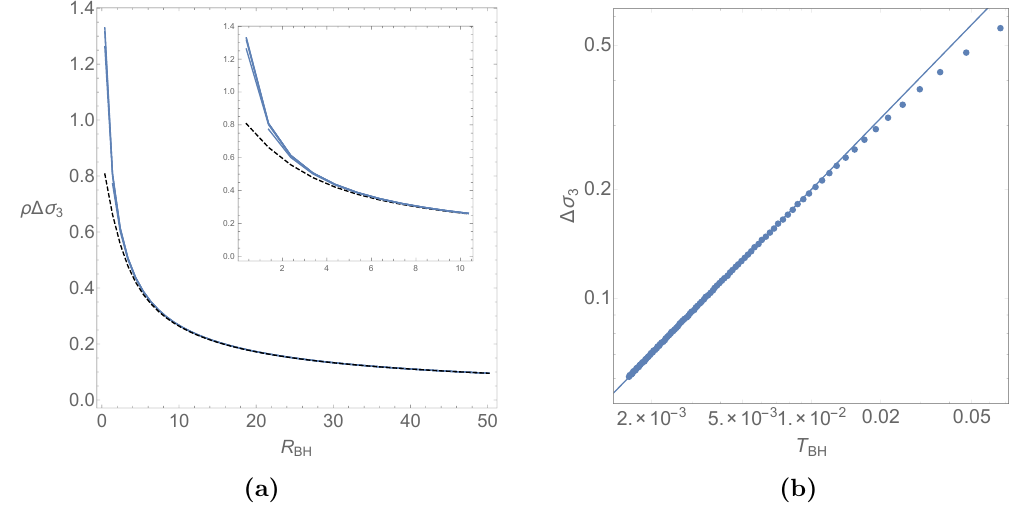
Figure 7. In (a), we plot (cid:26) (cid:1) (cid:27) 3 for (cid:26) = 1 (black, dotted line) ; 2 ; 3 ; 10 ; 20 ; 100 as a function of R BH . In scaling by (cid:26) , the area curves nearly perfectly overlap and the entanglement entropy has a universal behavior. Near the horizon (inset plot), there is some deviation, especially for (cid:26) = 1 (black dotted line) but the discrepancy disappears for (cid:26) larger than (cid:24) 2 ( (cid:26) increases from bottom to top). In (b), we show a log-log plot of the horizon entanglement as a function of T BH = (4 (cid:25)(cid:22) ) (cid:0) 1 . The line that we plotted shows this grows as T 2 = 3 BH